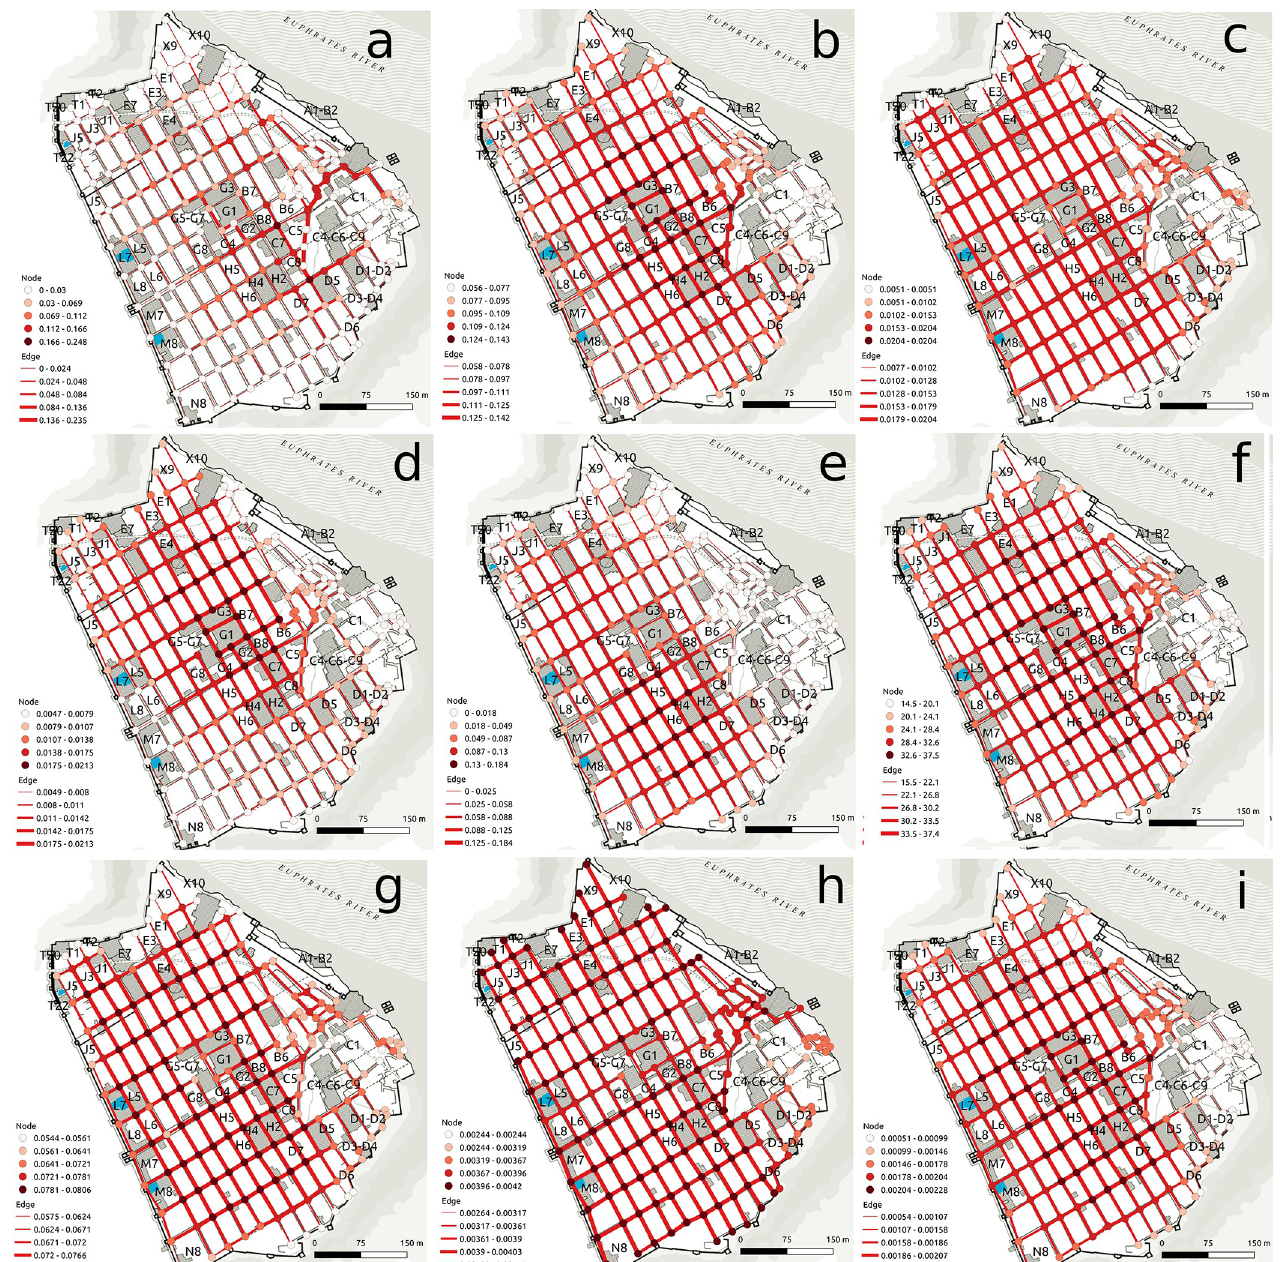
Fig 2. Geographic representation of centrality measures for streets in the ancient town of Dura Europos in modern Syria. Centrality measures include betweenness (a), closeness (b), degree (c), efficiency (d), eigenvector (e), harmonic (f), Katz (g), straightness (h), and current flow (i). The background maps used is reprinted under a CC BY 4.0 license with permission from Yale